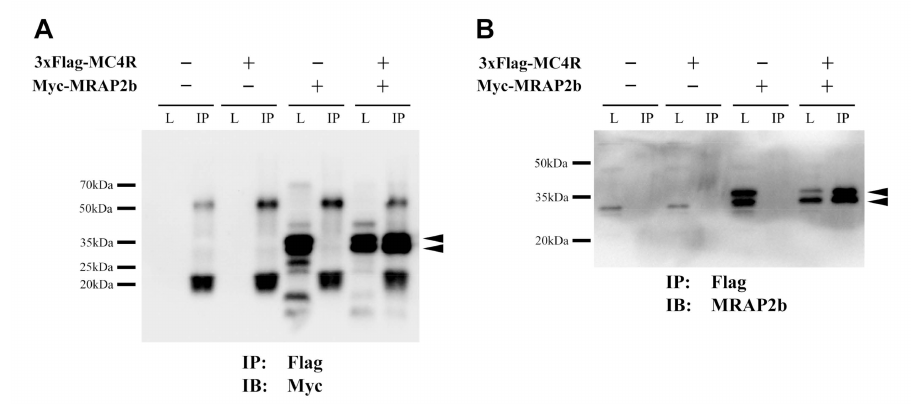
Figure 6. Interaction between tilapia MRAP2b and MC4R. Co-IP assays show the interactions between tilapia MRAP2b and MC4R expressed in CHO cells detected by di ff erent antibodies ( A : anti-Myc-tag; B : anti-MRAP2b). Arrow heads indicate the positive tilapia MRAP2b bands ( ≈ 35 kDa) in immunoprecipitated samples (IP) detected by the anti-Myc-tag ( A ) or anti-MRAP2 antibody ( B ). The ratio of MC4R to MRAP2b plasmid used is 1:5 ( w / w ). L, cell lysates; IP, immunoprecipitated samples (Anti-Flag antibody used); IB, immunoblotting (anti-Myc-tag antibody / anti-MRAP2 antibody used). Note , the two MRAP2b bands (marked by arrowheads) detected are likely caused by N -glycosylation at the N -terminus (Figure 2).